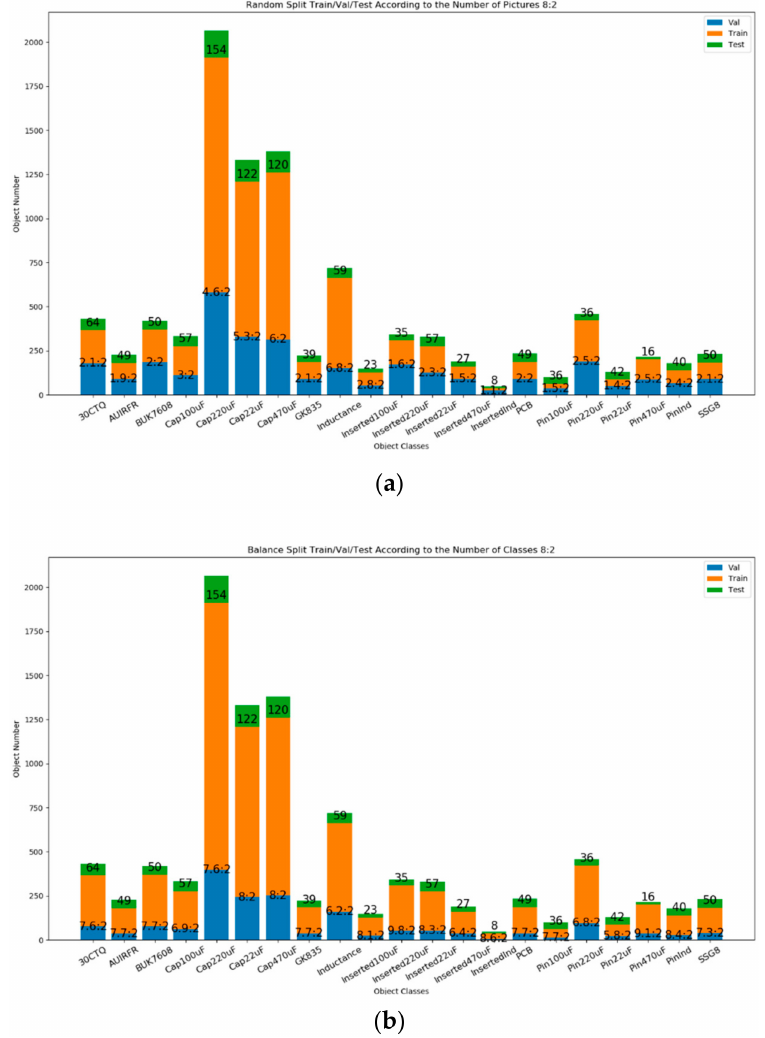
Figure 7. Statistics chart of the number of classes in two ways of splitting the dataset. ( a ) Randomly split Train/Val (train_picture_number:val_picture_number = 8:2). ( b ) Class-balanced Train/Val split (train_calss_number:val_calss_number =